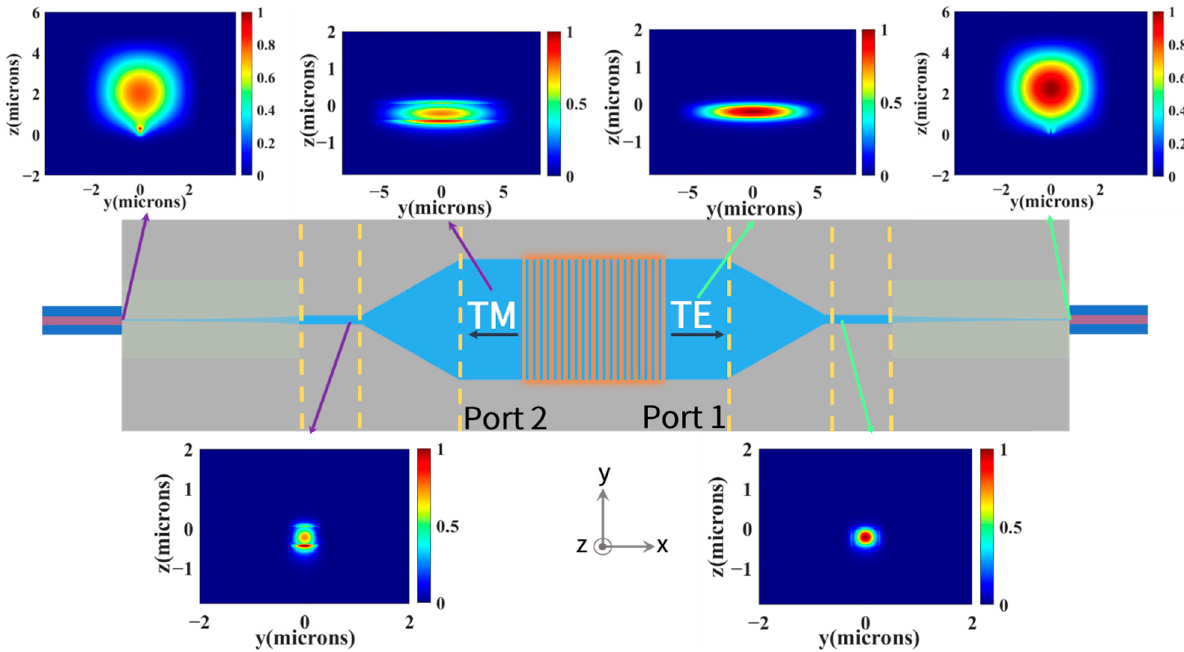
Figure 10. Mode field distribution at different positions of the polarization-splitting grating coupler with horizontal integration. The planar waveguide modes on Port 1 and Port 2 were located and converted to single-mode strip waveguide, and then efficiently coupled into lensed fibers through the optimized inverse taper.